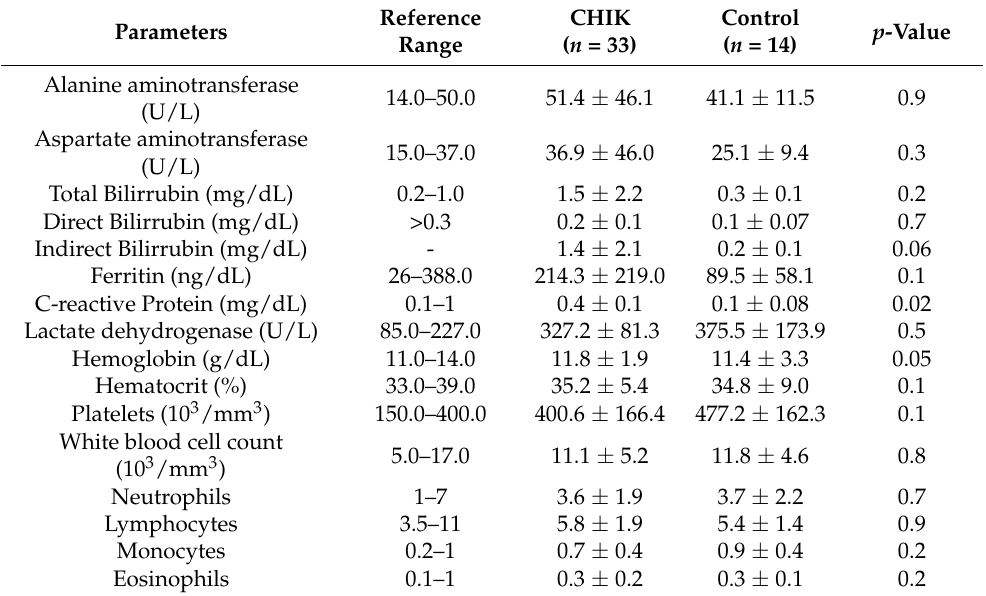
Table 2. Hematological and biochemical values of infants exposed intrauterine to CHIKV mother